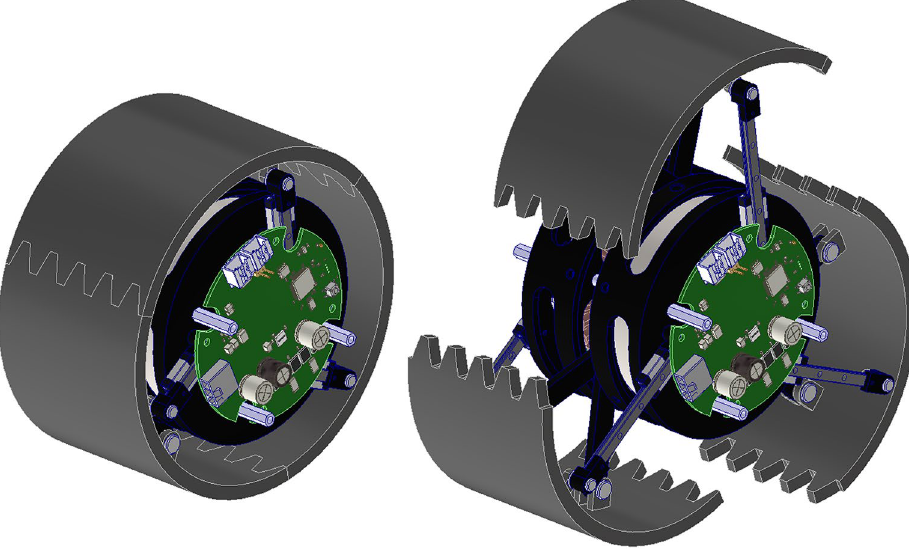
Figure 1. CAD model of the transformable wheel. The three lobes that form the rim of the wheel have two DOFs generated by two BLDC motors inside the wheel, which can transform into leg shapes capable of climbing